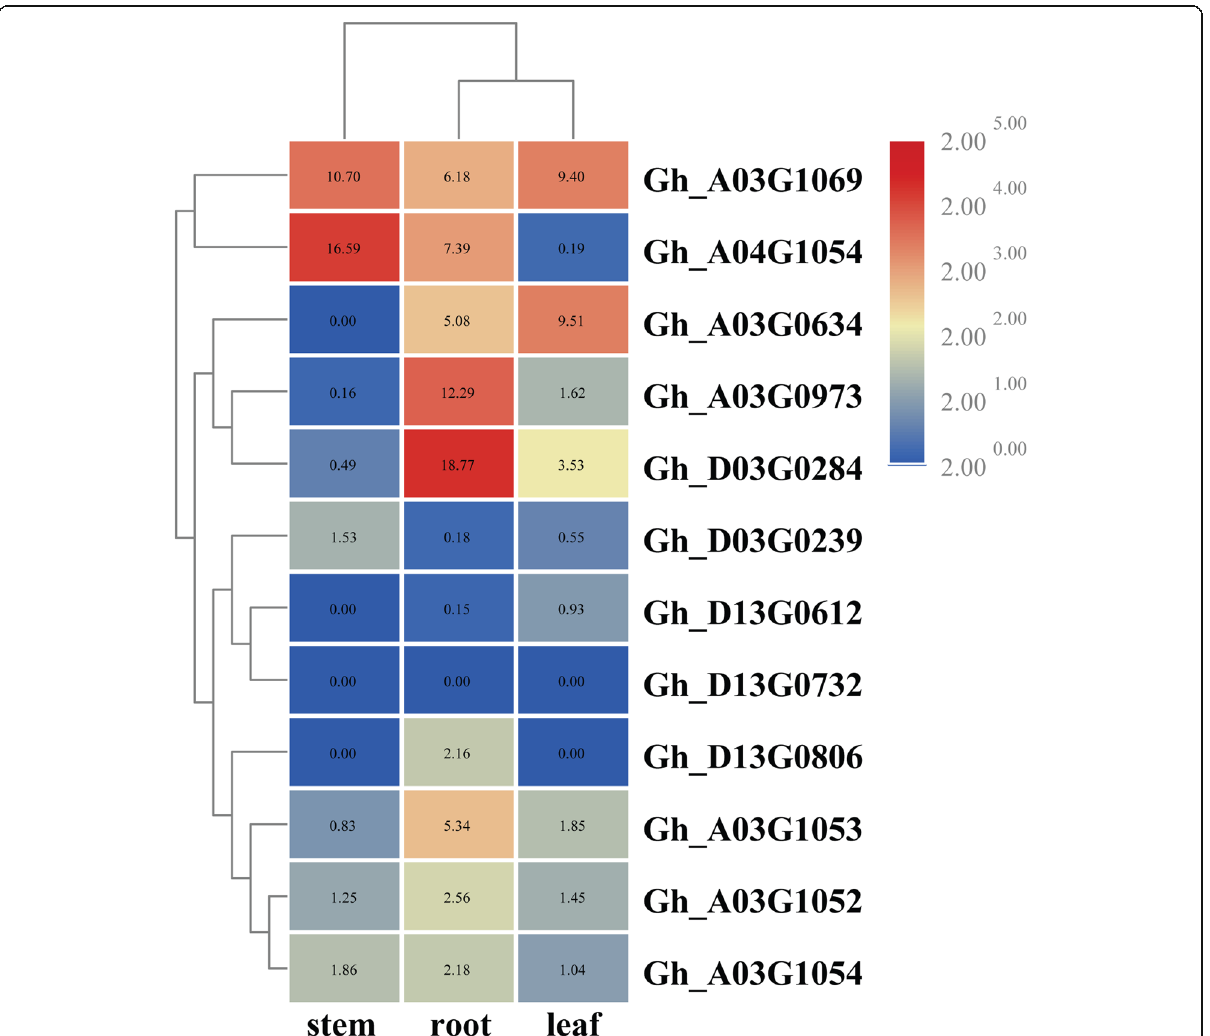
Fig. 3 The expression information of the important candidate genes for target traits in TM-1. Note: The data is the original expression data in expression